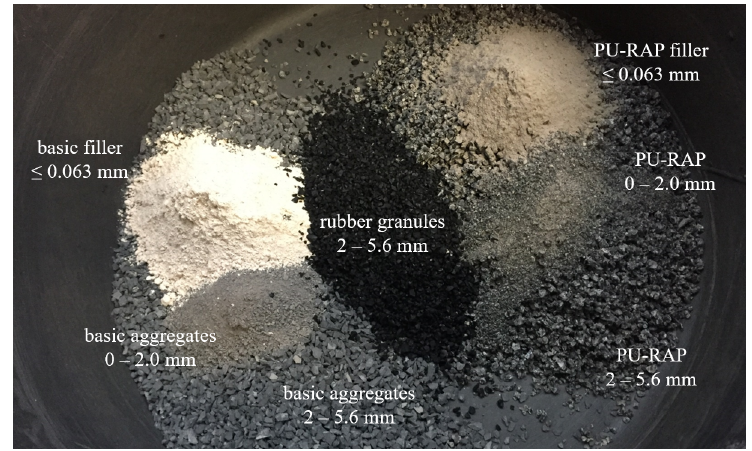
Figure 2. PU-RAP and basic material in visual